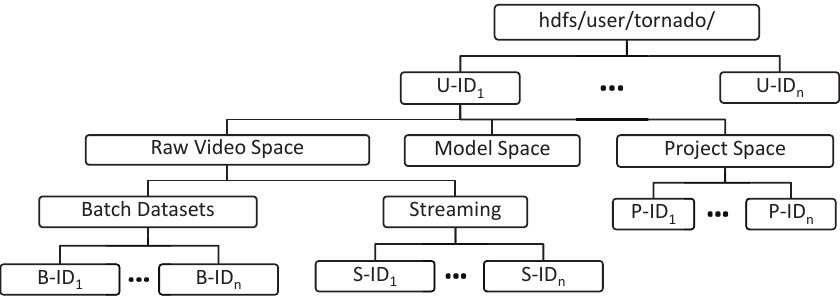
Figure 9. Realization of the hierarchical structure of user space in the Hadoop Distributed File System